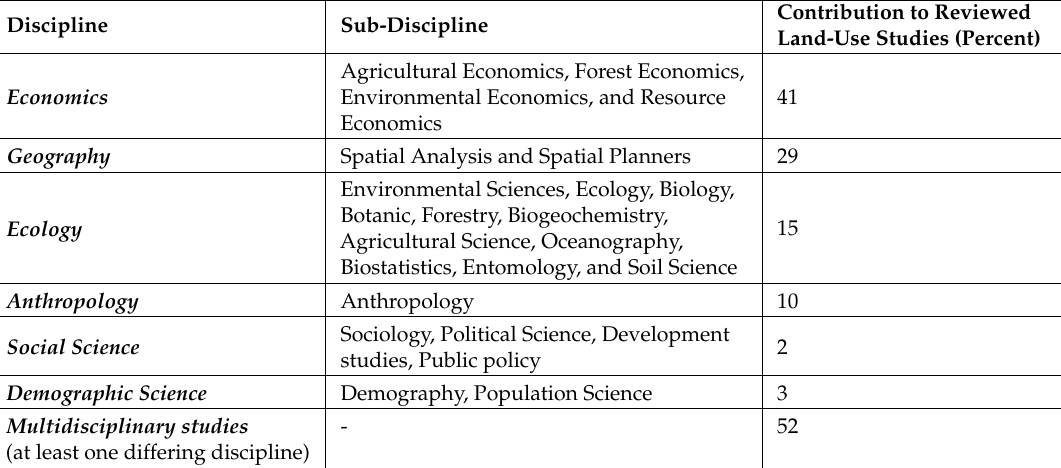
Table 3. Scientific disciplines in micro-Level and land-use change case studies reviewed. Discipline Sub-Discipline